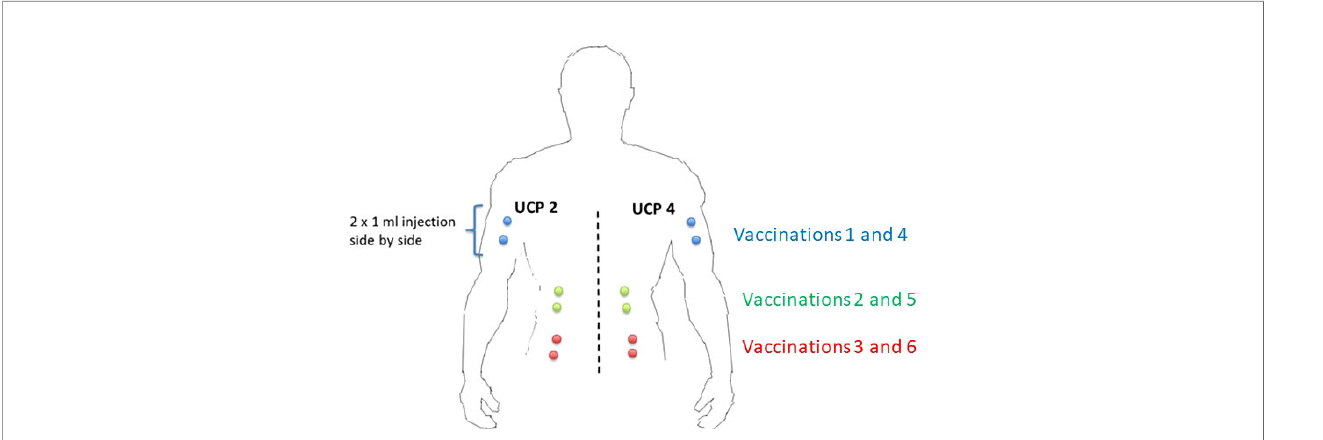
FIGURE 1 | Injection sites of each peptide. The two UCPVax peptides, UCP2 and UCP4 at 1 mg/ml (combined with Montanide ISA51 as adjuvant), will be injected subcutaneously in two separate sites (one site per peptide) at days 1, 8, 15, 29, 36, and 43 (priming phase) following by boost vaccinations: every 6 weeks for the two fi rst boosts (W13 and W19) and every 9 weeks afterward (W28, W37, and